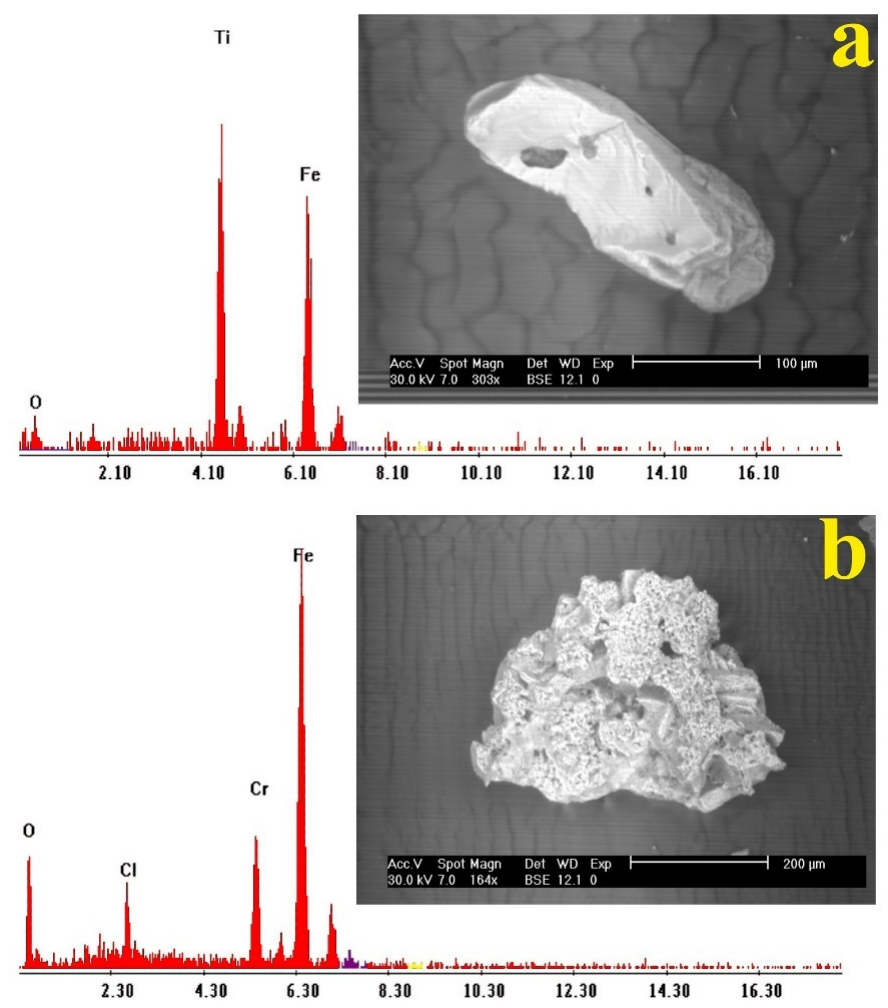
Figure 2. SEM/EDX of ( a ) ilmenite (sample 3) and ( b ) chromite (sample 3).